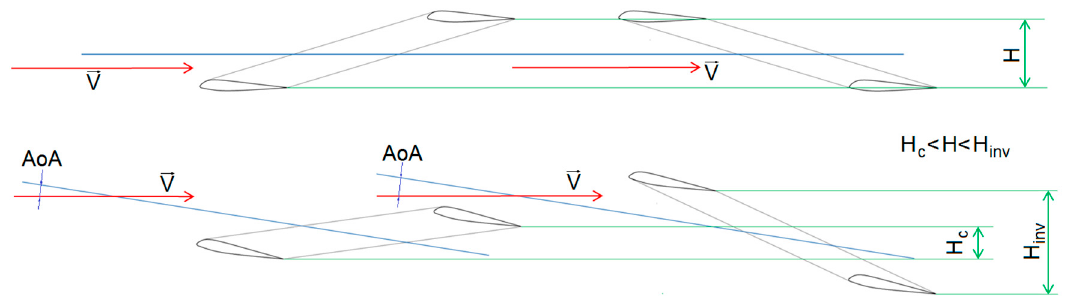
Figure 1. Distance between wings in conventional and inverted joined wings. Variation with angle of attack.